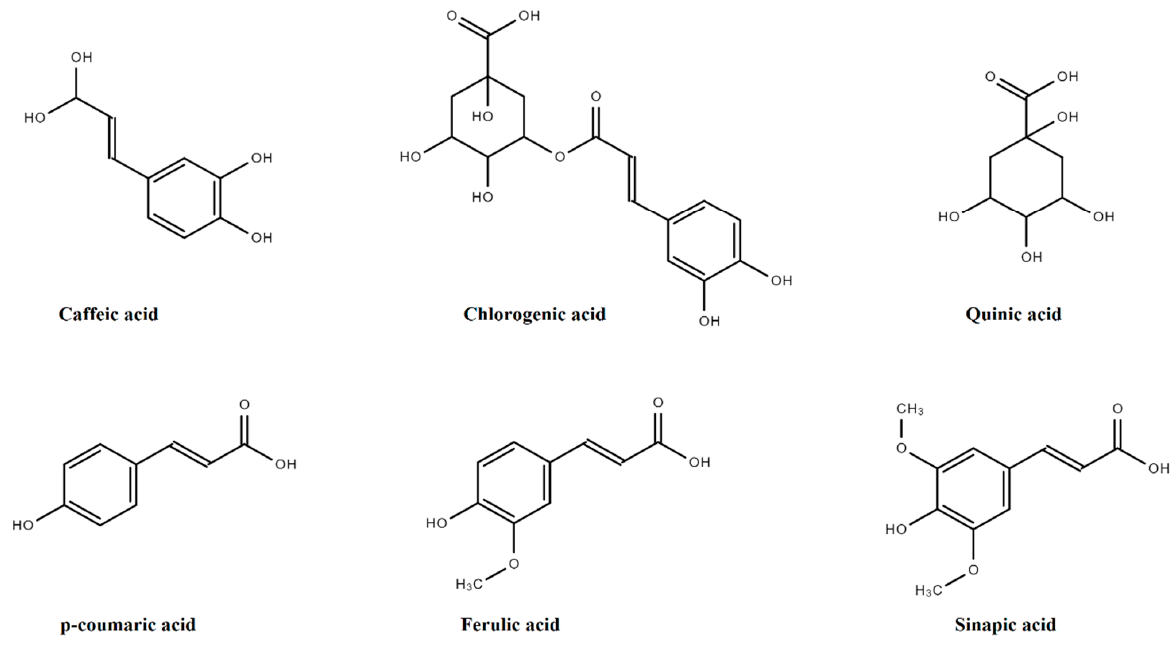
Figure 4. Derivatives of hydroxycinnamic acids.